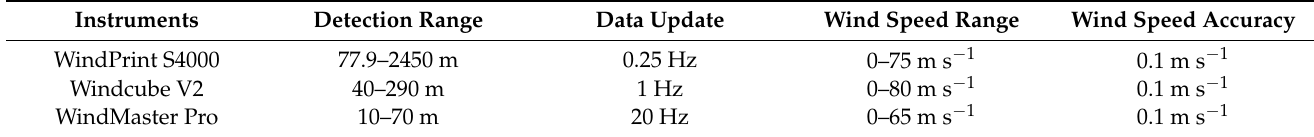
Figure 2. Instruments used for the joint observations. ( a ) Windprint S4000 DWL, ( b ) Windcube V2 DWL, and ( c ) WindMaster Pro three-dimensional ultrasonic anemometer. DWL, and ( c ) WindMaster Pro three-dimensional ultrasonic anemometer. Table 2. Main performance parameters of the different instruments. Table 2. Main performance parameters of the different